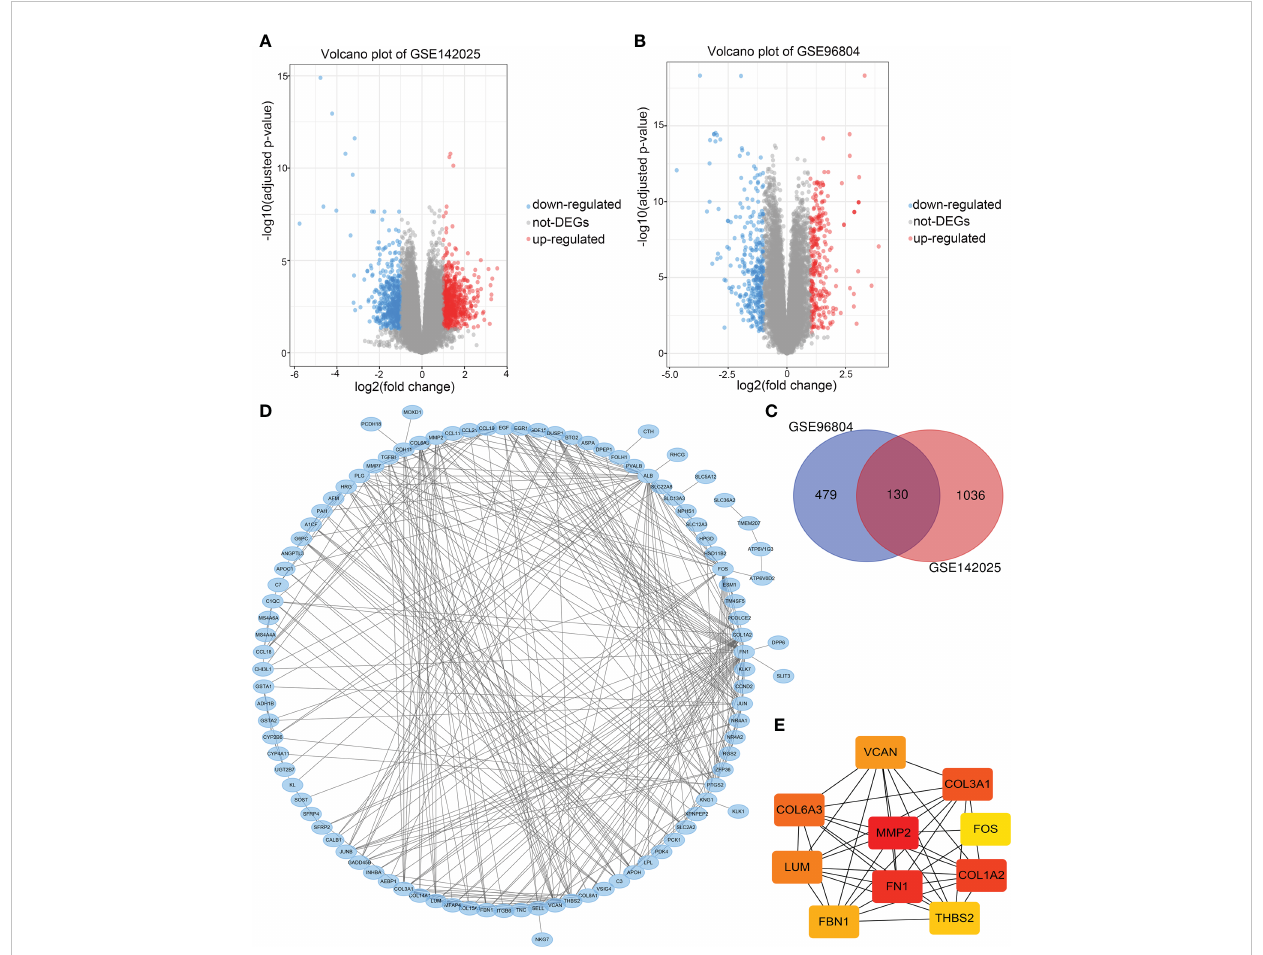
FIGURE 2 (A) Volcano maps of differentially expressed genes in data sets GSE1422025, (B) GSE96804. (C) Common differentially expressed genes in the two data sets. (D) PPI network of differentially expressed genes. (E) The PPI network of the top 10 Hub